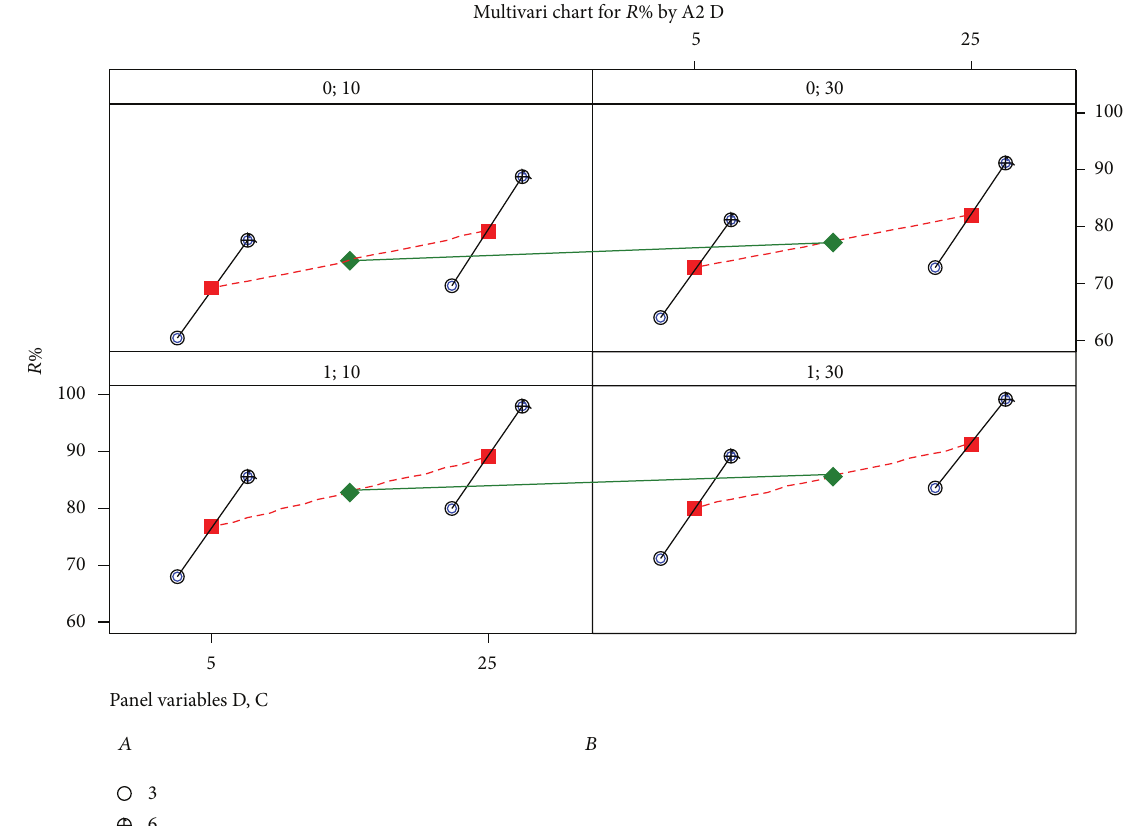
Figure 8: Multivari chart for analyzed